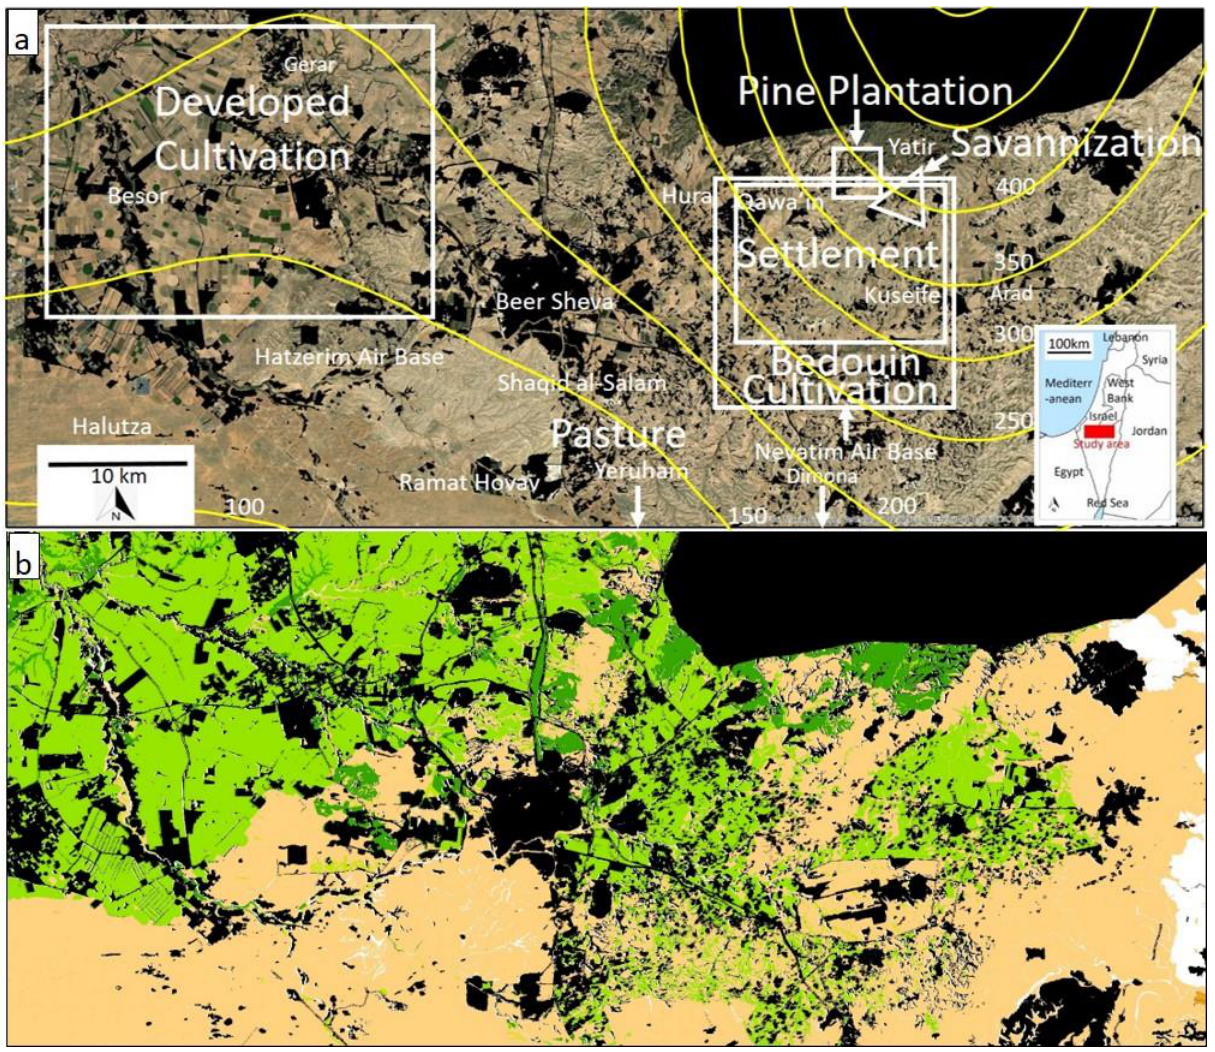
Figure 1. Study area. ( a ) Names of locations mentioned in the text, isohyets [18] in yellow, and detailed study areas. ( b ) IGU land use classification [22]. Land use types are indicated by color and IGU LU class composition in parentheses: black and white (600)—excluded areas—mainly habitation and other buildings; tan, pasture (601, 603, 606, 611, 612, and 616); light green, cultivation (608); dark green, planted forest (624): background image in ( a ) from Google Earth, inset modified from Geolounge. Table 1. The six land use types used in the study, and locations of detailed study sites (also shown in Figure 1). Land use from [23] and JNF (Jewish National Fund, Keren Kayemet LeYisrael) [personal communication], and soil types from [24]. Land Use (LU)